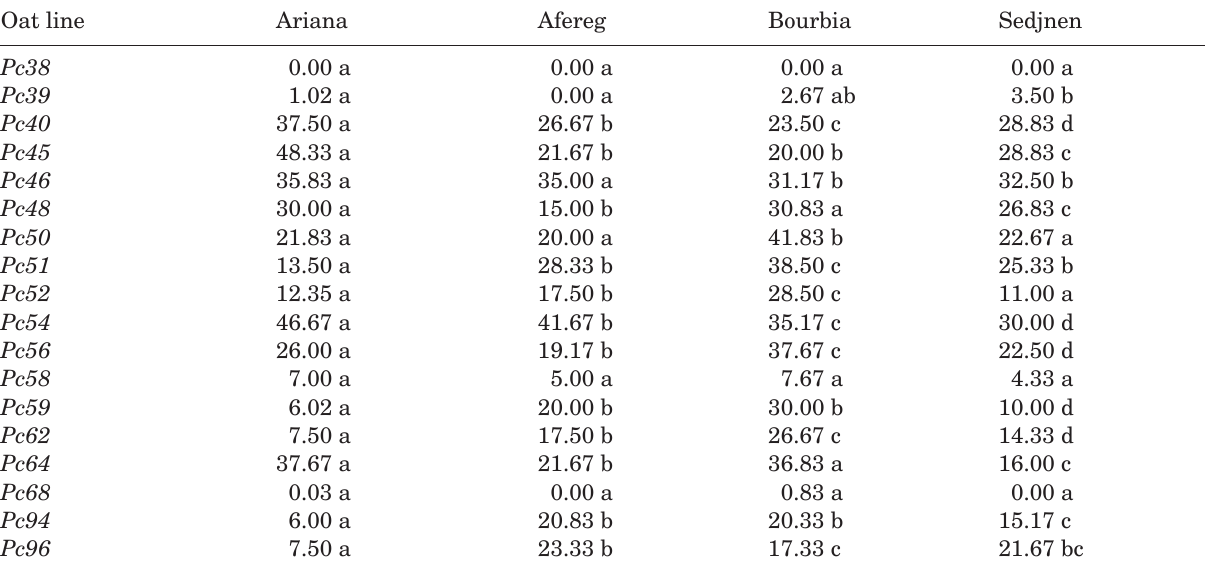
Table 2. Mean natural crown rust percentage on 18 differential oat lines cultivated in four areas of Tunisia from 2002 to 2007.